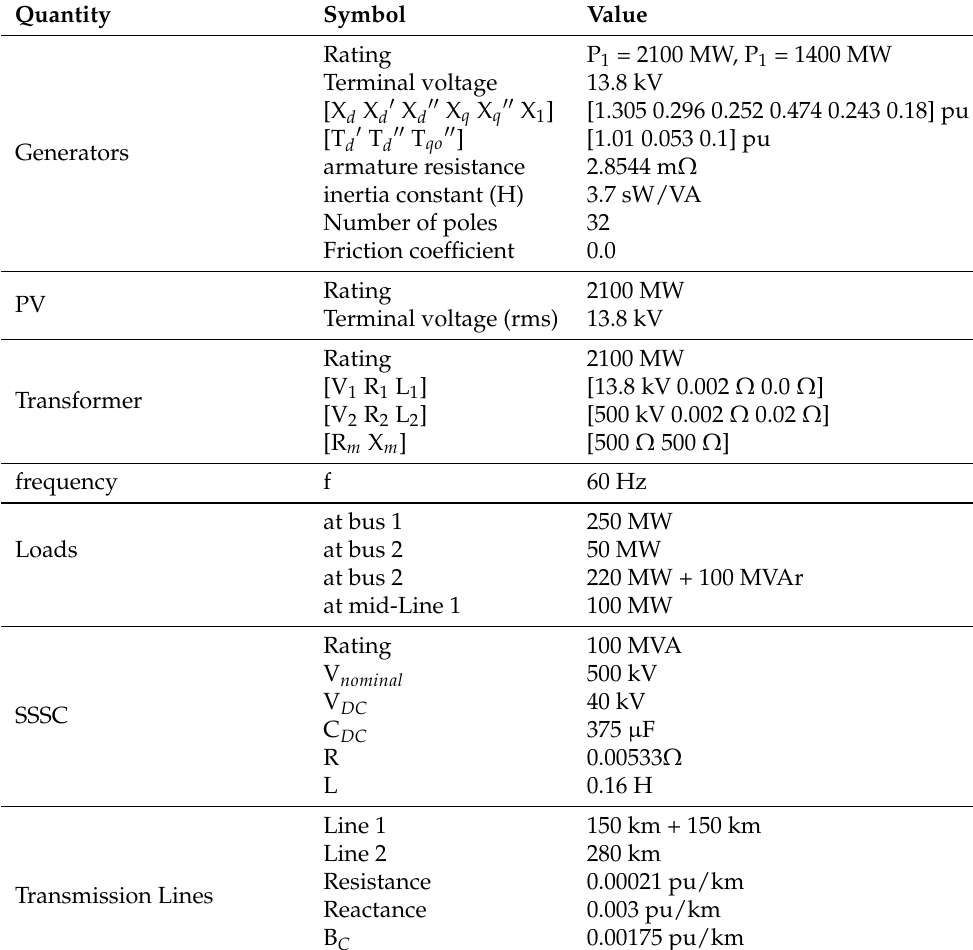
Table A1. Parameters of the two-area power